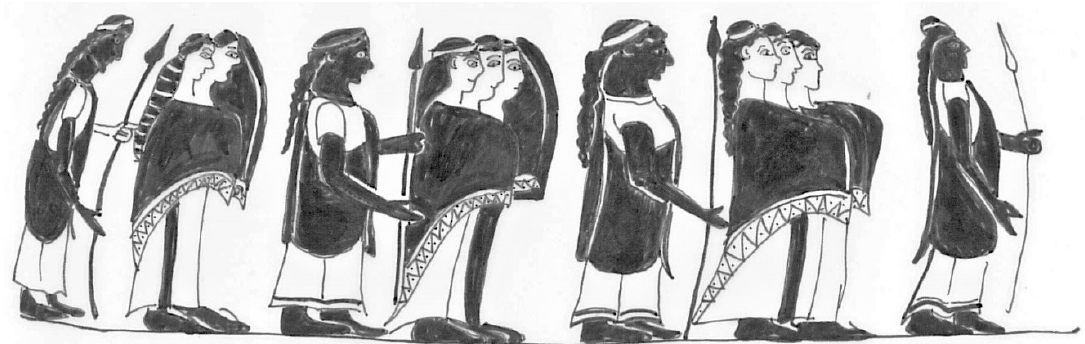
Figure 7. Corinthian column crater. Basel, Antikensammlung BS444. Maybe from Argos. Ca. 580–570 BCE. Drawing by the author.